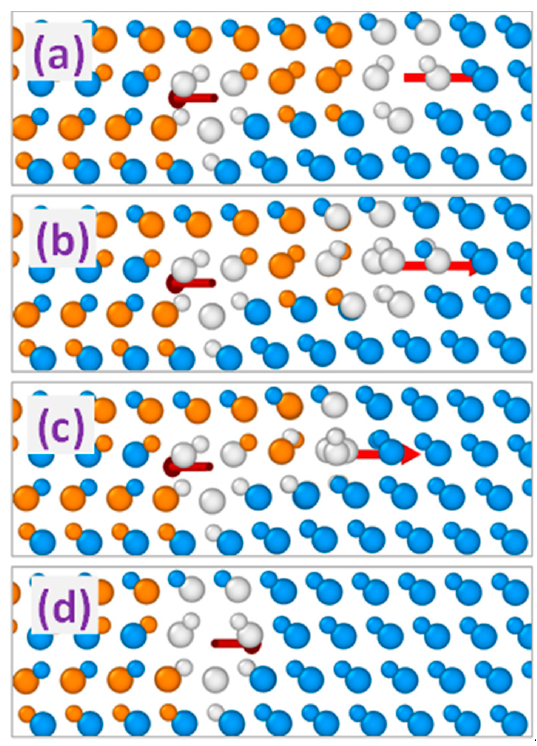
Figure 3. MD s imulated evolution of the interaction of 30° and 90° partial dislocations forming the 30° extrinsic partial dislocation. Simulated time: ( a ): 0, ( b ): 20, ( c ): 50, and ( d ): 100 ps, respectively. Arrows indicate the directions of the Burgers vectors of the partial dislocations ( a – c ) and the dislocation complex ( d ).